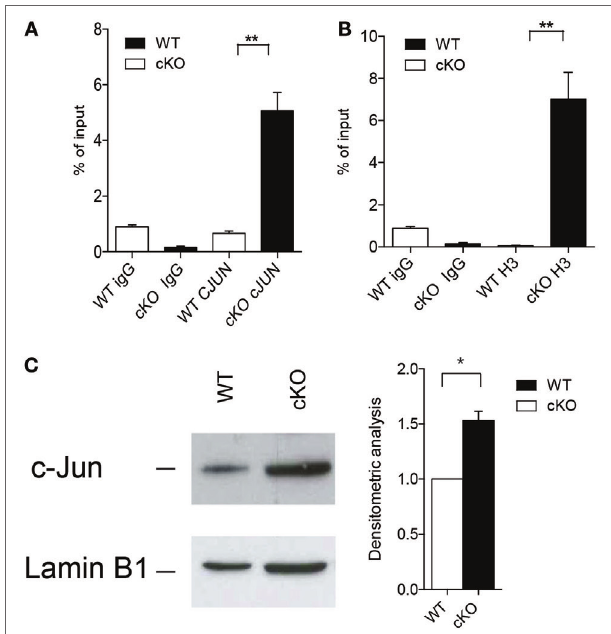
FigUre 4 | Lack of glucocorticoid-induced leucine zipper (GILZ) in B cells increases the production of IFN- γ via enhanced AP-1 transcriptional activity. (a,B) Chromatin immunoprecipitation analysis of the ifng promoter in spleen cells of wild-type (WT) and gilz B cKO mice with anti-c-Jun antibody (a) or anti-acetylated histone H3 [ (B) ; n = 9]. Statistical analysis was performed using the unpaired Student’s t -test (** p < 0.005). (c) Western blot analysis of nuclear c-Jun levels in purified B cells from spleens of WT and gilz B cKO mice. The graph on the right shows the results of densitometry analysis of c-Jun relative to the housekeeping gene lamin B1. Statistical analysis was performed using the nonparametric Mann–Whitney U test (* p <